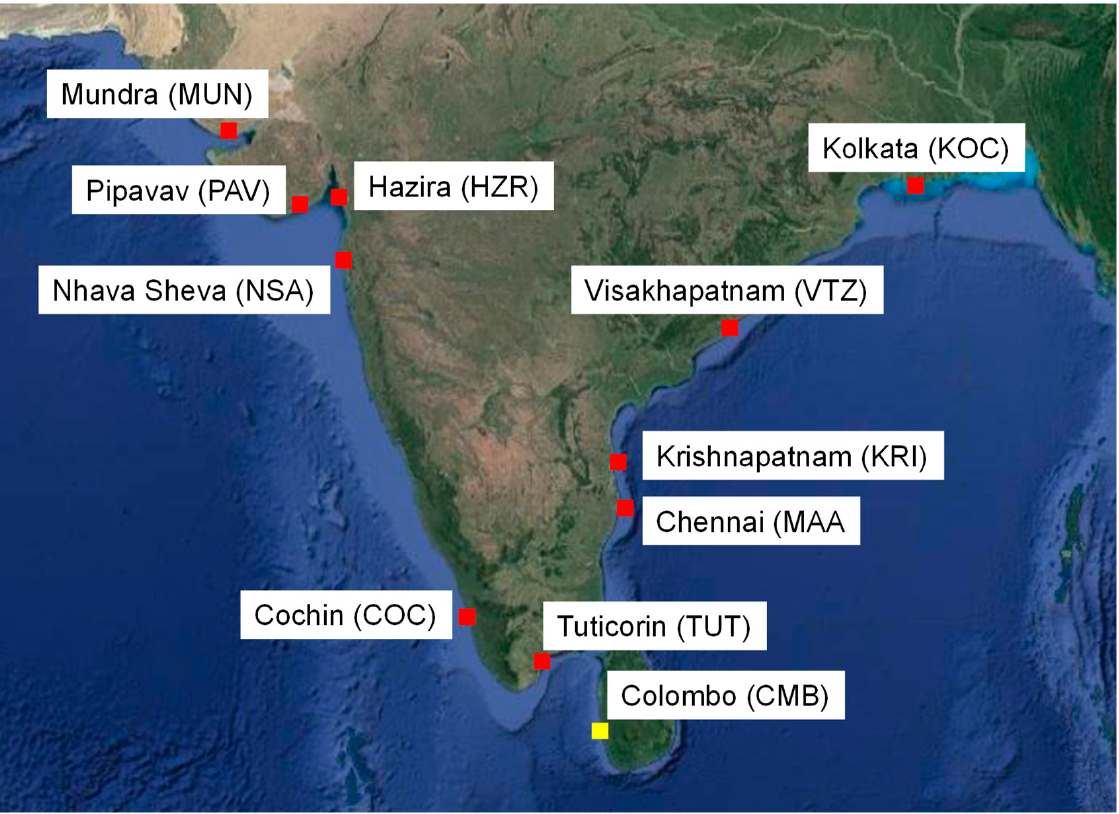
Figure 1. Location of Colombo and Indian ports. Source: Google map modified by authors. Table 1. Statistics of Colombo and Indian ports in 2015.